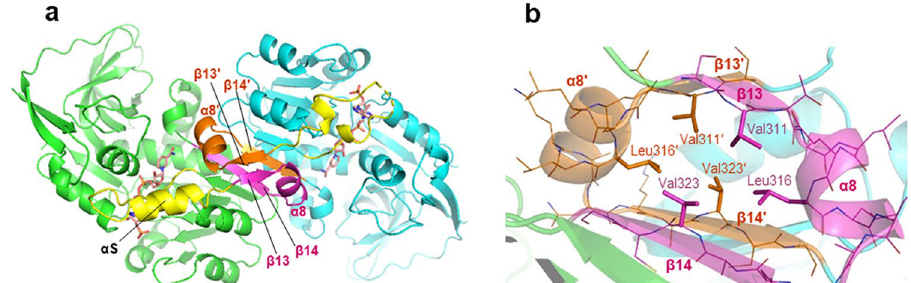
Figure 2. VAT-1 dimer. ( a ) The VAT-1 homodimer in the NADP-bound form. The bound NADP molecules are shown as stick models (orange). The β13–α8–β14 segment of each VAT-1 protomer forms the βαβ motif. The βαβ motif (magenta) of VAT-1 mol A (green) and the βαβ motif (orange) of mol B (cyan) mediates the dimer interface by forming intermolecular antiparallel associations between β13 and β13 ′ strands, and β14 and β14 ′ strands. ( b ) The βαβ motifs from two protomers build a compact module by forming a mini hydrophobic core with hydrocarbon side chains from Val311 (at β13 strand), Leu316 (α8 helix) and Val323 (β14